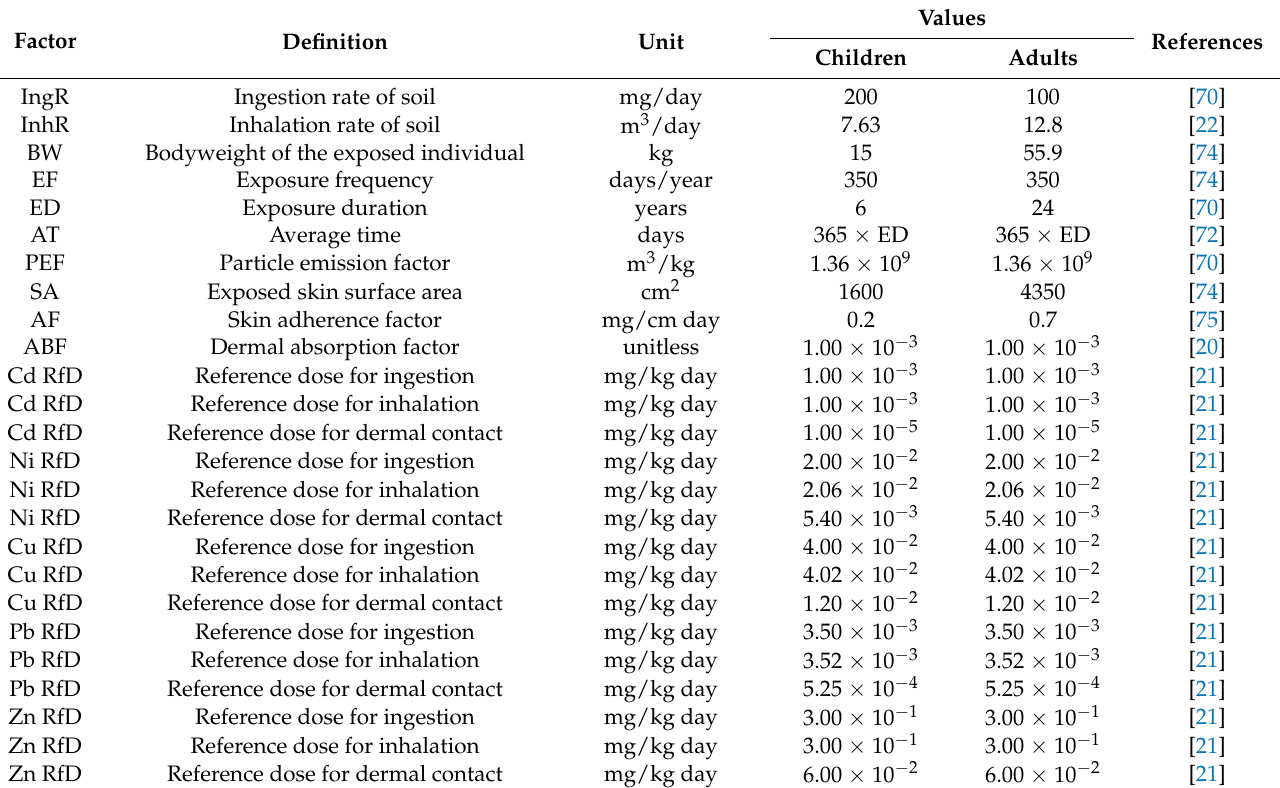
Table 3. Definition, exposure factors and reference values used to estimate the intake values and health risks of potentially toxic metals in topsoils collected from Peninsular